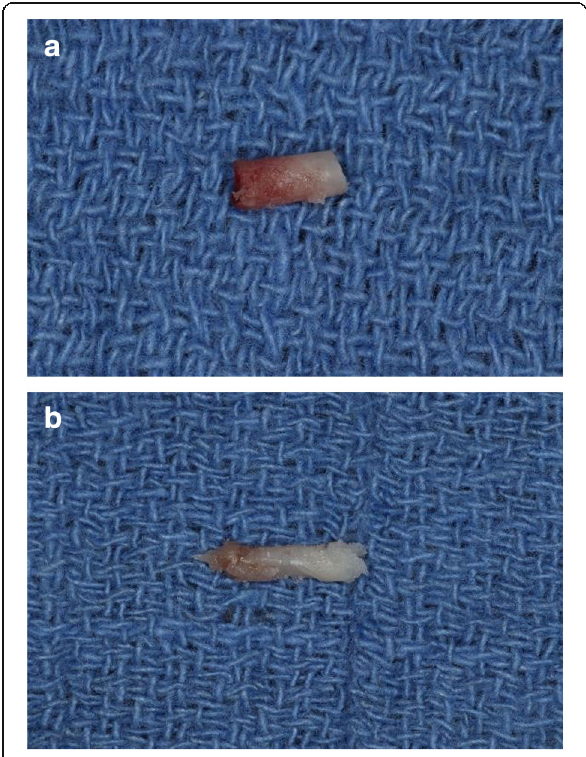
Fig. 6 a and b Core samples retrieved from anterior and posterior sinus regions